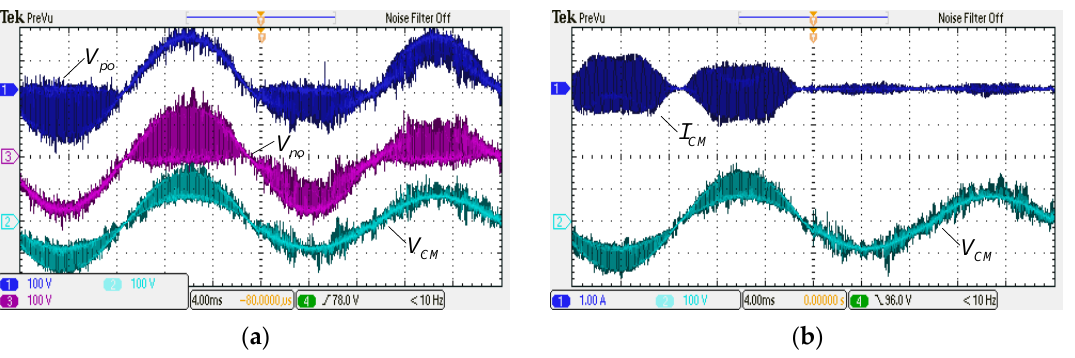
Figure 11. The dynamic experimental results from CH4 to CH5 inverter. ( a ) V po and V no ; ( b ) Leakage current and CMV.